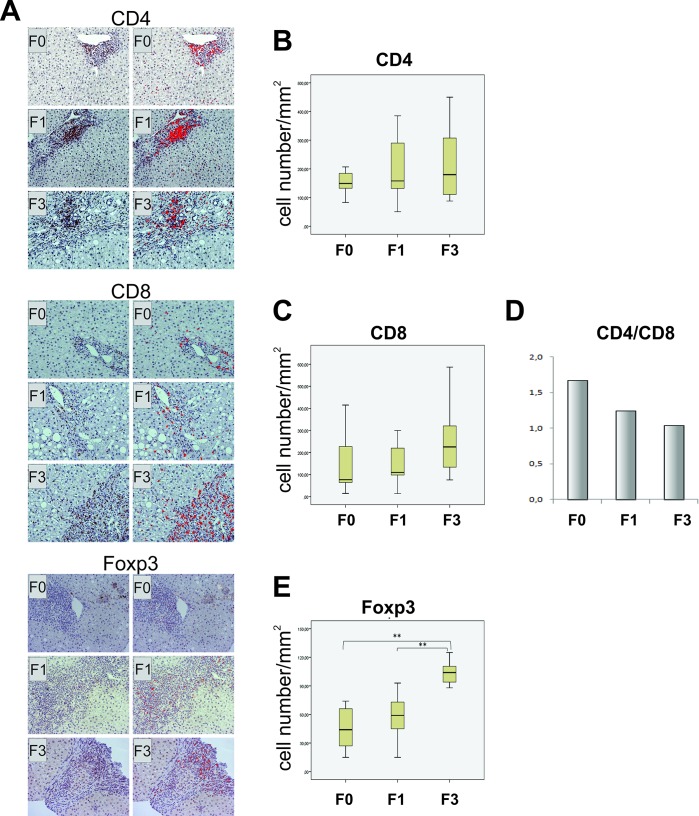
Immunohistochemical analysis of T cells in liver biopsy specimens from patients in different stages of fibrosis (F0, F1, F3).(A) Liver biopsy specimens were stained for CD4, CD8 and Foxp3, photographed, and images (left columns) were processed using ImageJ software (right columns). The results of analysis are presented by box plots as the number of positive cells per mm2 (B, C, E). The proportion of CD4 and CD8 lymphocytes is presented as CD4/CD8 ratio (D). Asterisk reflects significance of difference: **p<0.001.